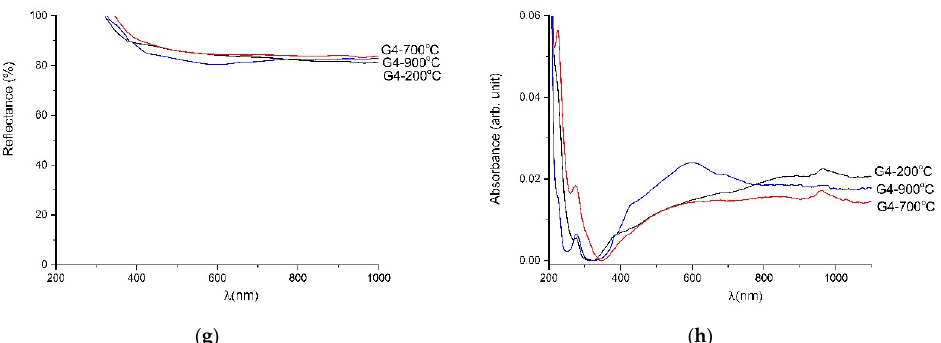
Figure 4. UV_VIS spectra listed as: ( a ) reflectance spectra of heat-treated G1 powders; ( b ) absorbance spectra of heat-treated G1 powders; ( c ) reflectance spectra of heat-treated G2 powders; ( d ) absorbance spectra of heat-treated G2 powders; ( e ) reflectance spectra of heat-treated G3 powders; ( f ) absorbance spectra of heat-treated G3 powders; ( g ) reflectance spectra of heat-treated G4 powders; ( h ) absorbance spectra of heat-treated G4 powders. Table 2 gives the band gap values estimated from Tauc plot and the Klubelka–Munk relation. The values vary between 1.2 eV for G1 heat-treated at 900 °C and 5.9 eV for G4 heat-treated at 900 °C.